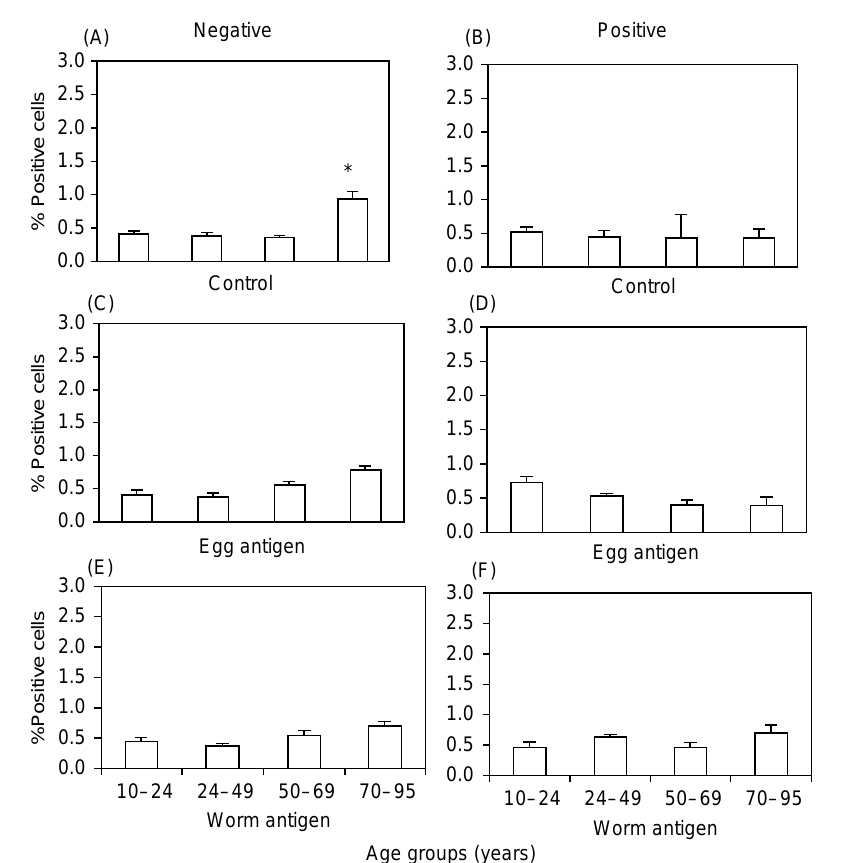
FIG. 2. Frequency of CD4 (cid:2) INF- g (cid:2) cells were analyzed according to age and infection status in individuals from areas endemic for schistosomiasis in Brazil. Seventy-three individuals from 10 to 95 years of age were analyzed in a cross-sectional study. Individuals who scored negative in the stool test for S.mansonieggs were taken as negative subjects (A, C, E) and individuals who scored (cid:1) / 100 eggs per gram of feces (epg) were taken as positive subjects (B, D, F). Freshly collected blood cells from both groups of individuals were cultured in complete RPMI for 5 h with either medium alone (control) (A, B), or 25 m g/ml of soluble egg antigen (egg antigen) (C, D) or 25 m g/ml of soluble worm antigen (worm antigen) (E, F). Cells were then stained for CD4 and for IFN- g and analyzed by flow cytometry. Bars represent the average frequency of CD4 (cid:2) IFN- g (cid:2) cells 9 / standard deviation of each age group. A one-way analysis of variance procedure was used to test differences among age groups, *significant differences. Pairs of means of negative and positive individuals at the same age group were tested by Bonferonni post-hoc test, (cid:2) / significant differences. p B /